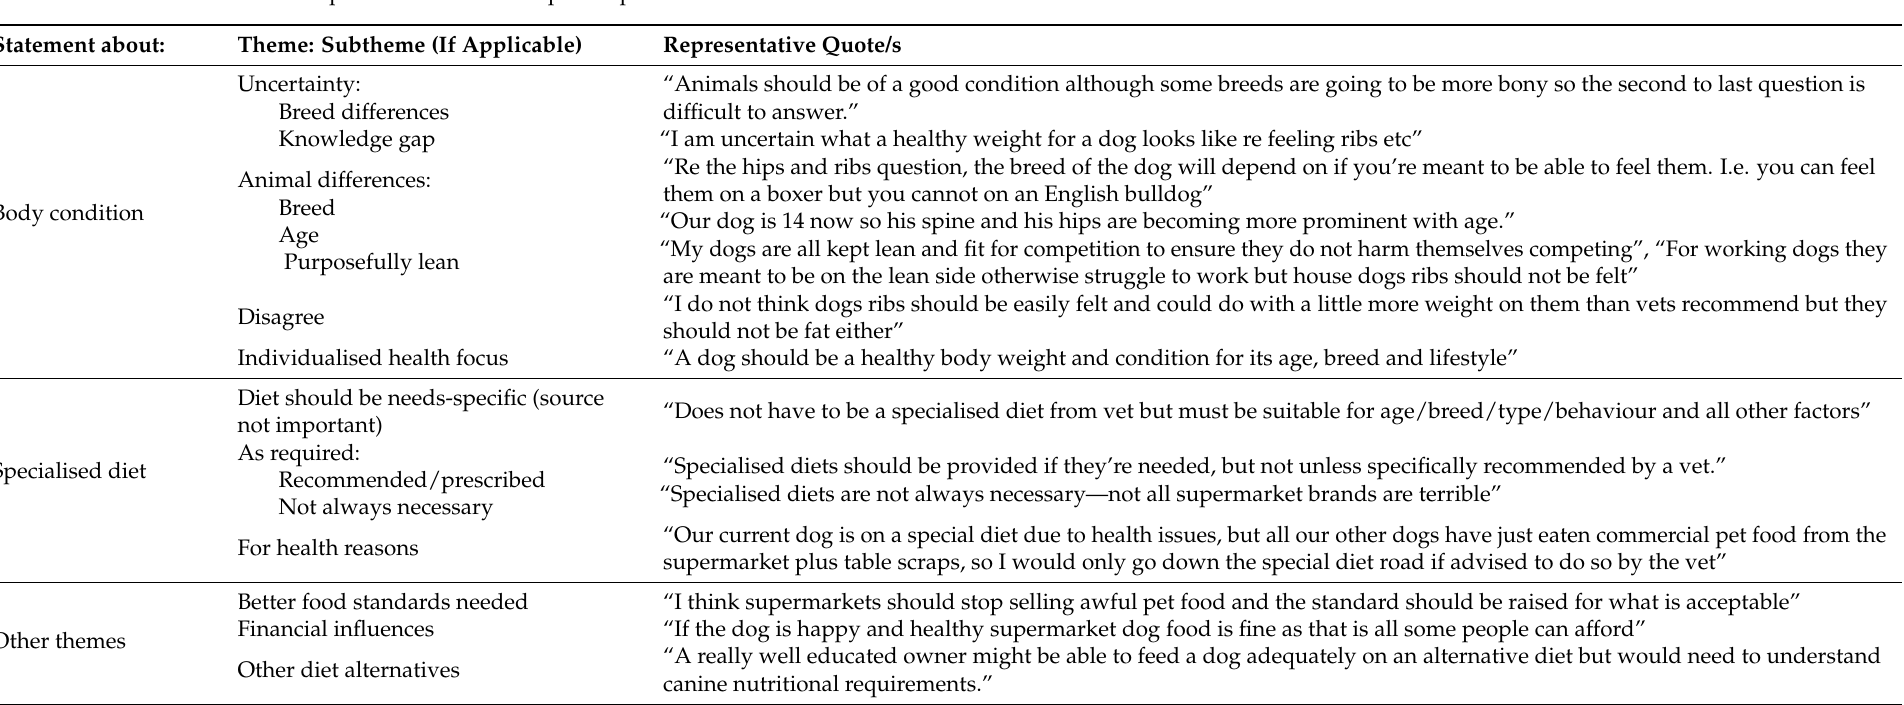
Table 4. Thematic analysis of comments provided by the EIT Pet Survey 2019. respondents when asked how strongly they agreed or disagreed with the following body condition and specialised diet statements, respectively: “Dogs should have ribs, hips, and a spine that are not visible but are easily felt” and “Dogs should have a specialised diet from a pet shop or vet